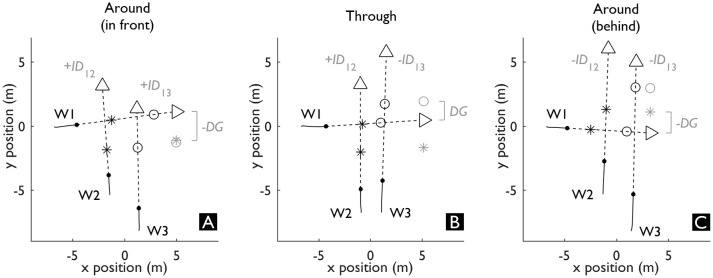
Positioning of all walkers in three exemplar triadic interactions where W1 was predicted to cross in front (A), through (B) and behind (C) the gap. The • indicates the current position of each walker. The solid lines up until • depict the trajectory up until the current point in time. The dashed lines from • denote the predicted trajectories upon which the future positions of each walker are visualized at the instant of minimal distance: tMD12 (*) and tMD13 (◦). The distance between each * and ◦ corresponds with the ID, which is projected on the right in each panel as a portal that Walker 1 (W1) is predicted to pass through (B) or not (A, C). DG is the distance to the closest side of the projected portal.